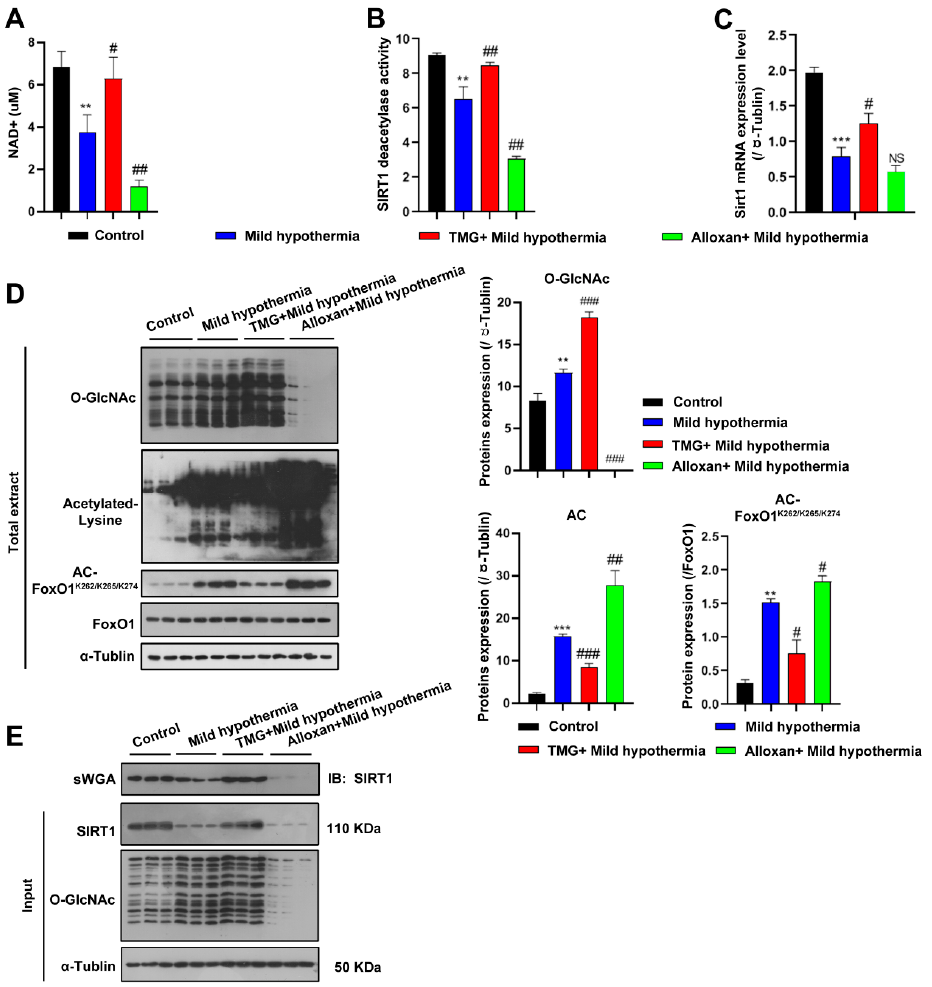
Figure 6. MHT increased acetylation through SIRT1 inhibition. ( A – C ) After 3 h of MHT at 32 ℃ ,